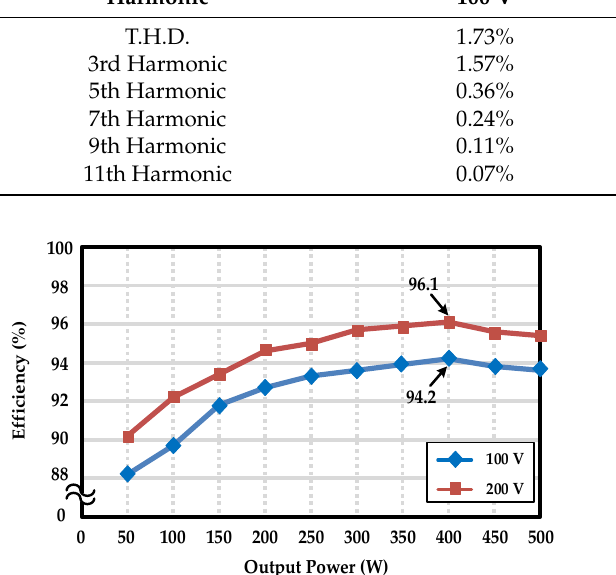
Figure 17. Measured efficiency curves of the proposed inverter.